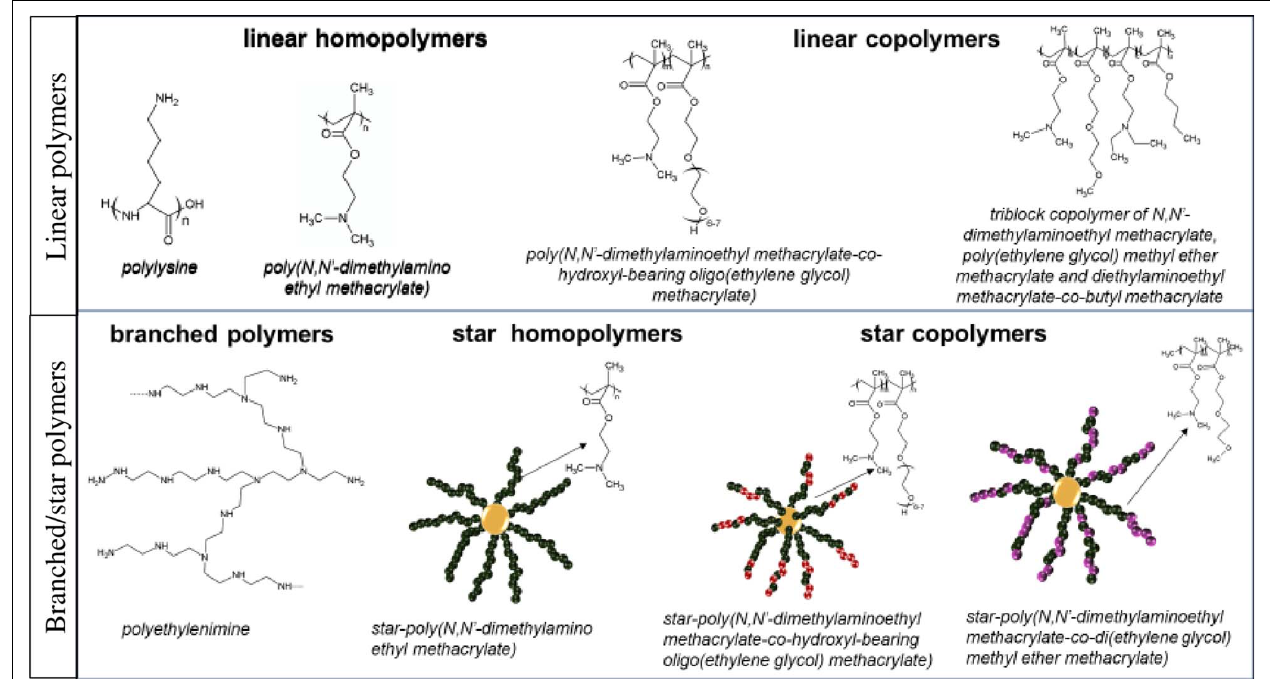
FIGURE 2 | Examples of cationic polymers used in gene delivery